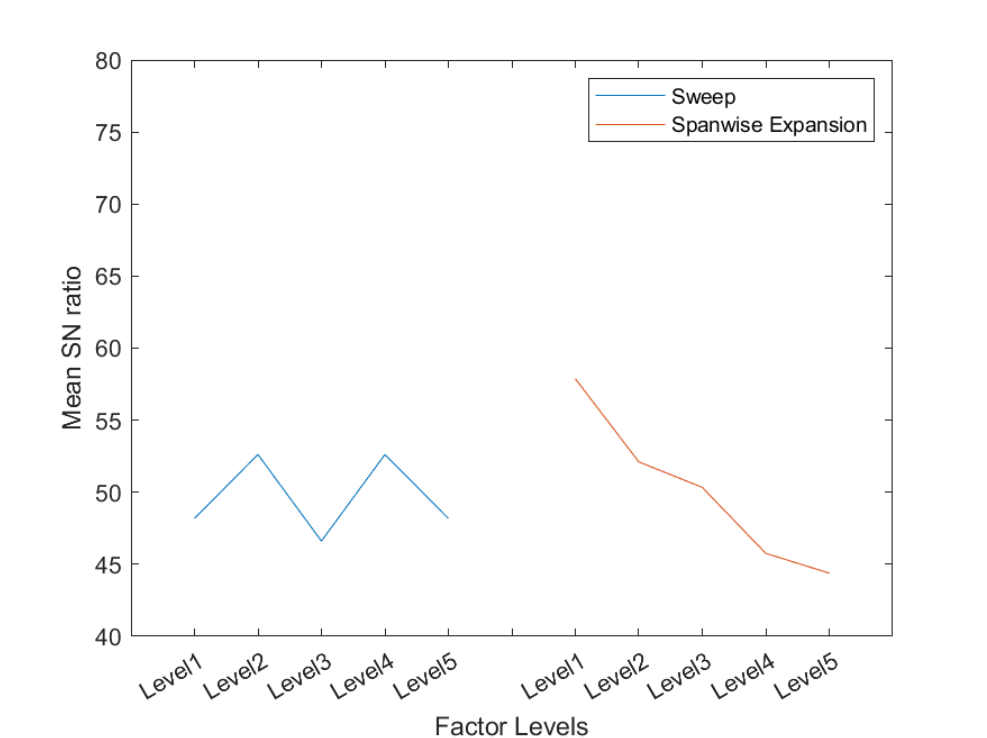
Figure 20. SN ratio for the eighth natural frequency of the morphed